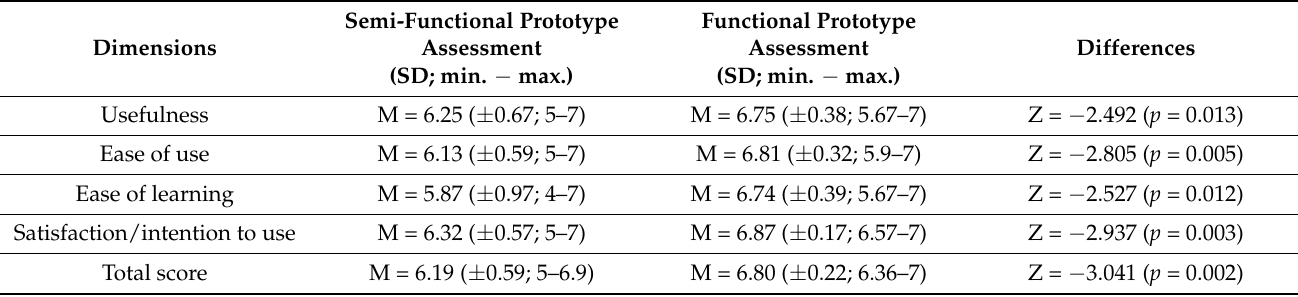
Table 3. Differences in usability scores between phase 1 and phase